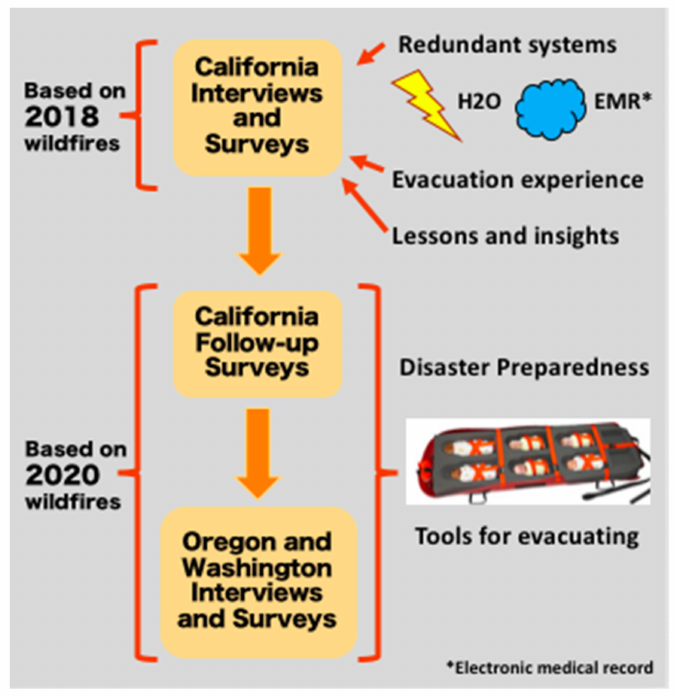
Figure 2. Methods schematic. The lightning bolt icon represents power; the cloud icon represents medical